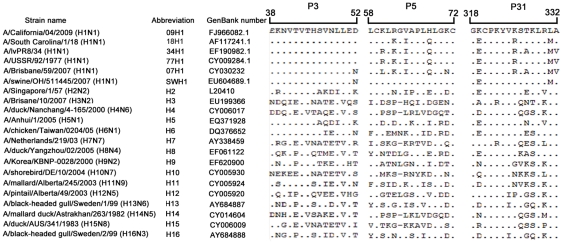
Alignment between the amino acid sequences of the peptides P3, P5, and P31 and the corresponding representative HA sequences of H1–H16 subtypes.Sequences of aa 38 to 52, 58 to 72, and 318 to 332 of the HA protein of A/California/04/2009 (GenBank number FJ966082.1) are aligned with the corresponding region of multiple HA proteins of H1–H16 subtypes and H1-subtype strains isolated in different years by BioEdit software.